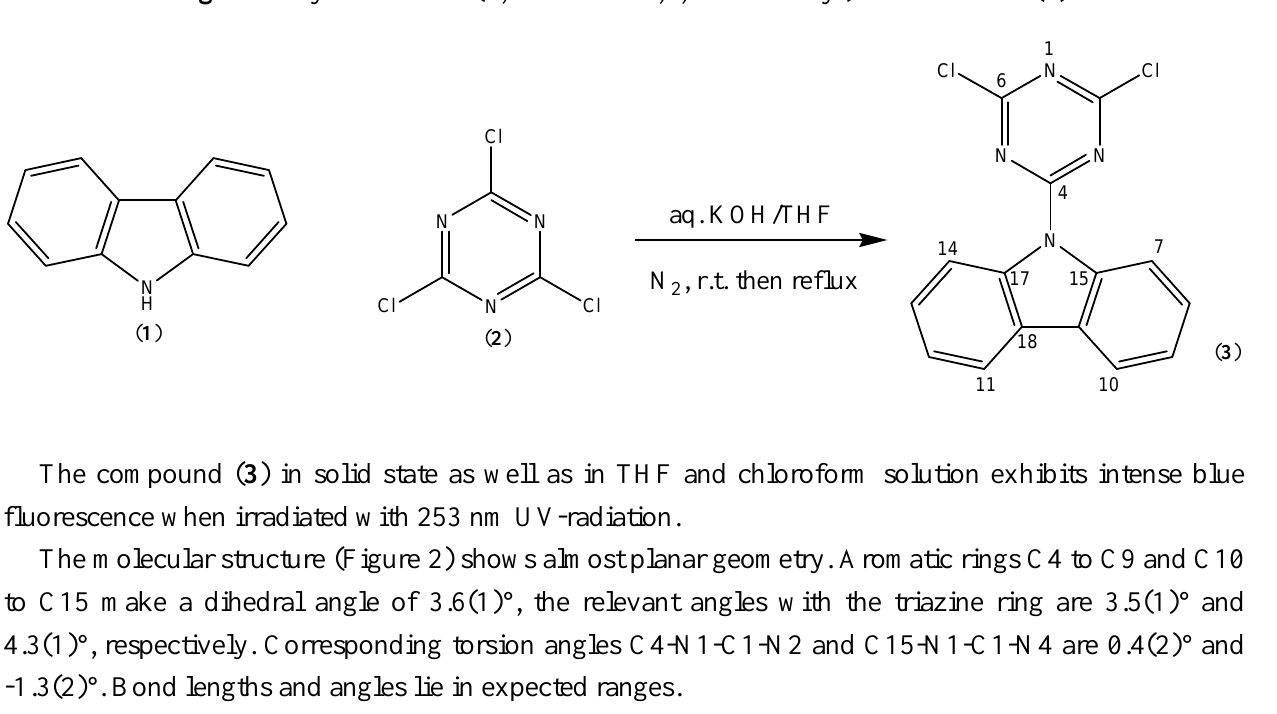
Figure 1. Synthesis of 9-(4,6-dichloro-1,3,5-triazin-2-yl)-9H-carbazole ( 3